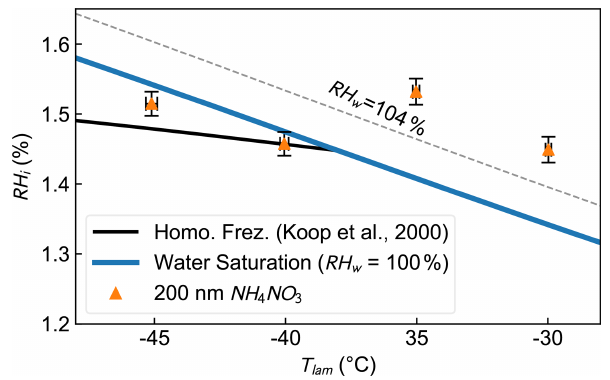
Figure B2. Phase diagram of the IN onset (below − 38 ◦ C) or wa- ter droplet detection in the > 5µm OPC channel (above − 38 ◦ C) for freezing or water droplet formation onto 200nm dry diameter am- monium nitrate particles. The solid blue and black lines represent the water saturation line and the homogeneous freezing threshold of 200nm aqueous droplets (Koop et al., 2000), respectively. The horizontal and vertical error bars represent the variation of temper- ature and RH i along HINC lamina centerline.